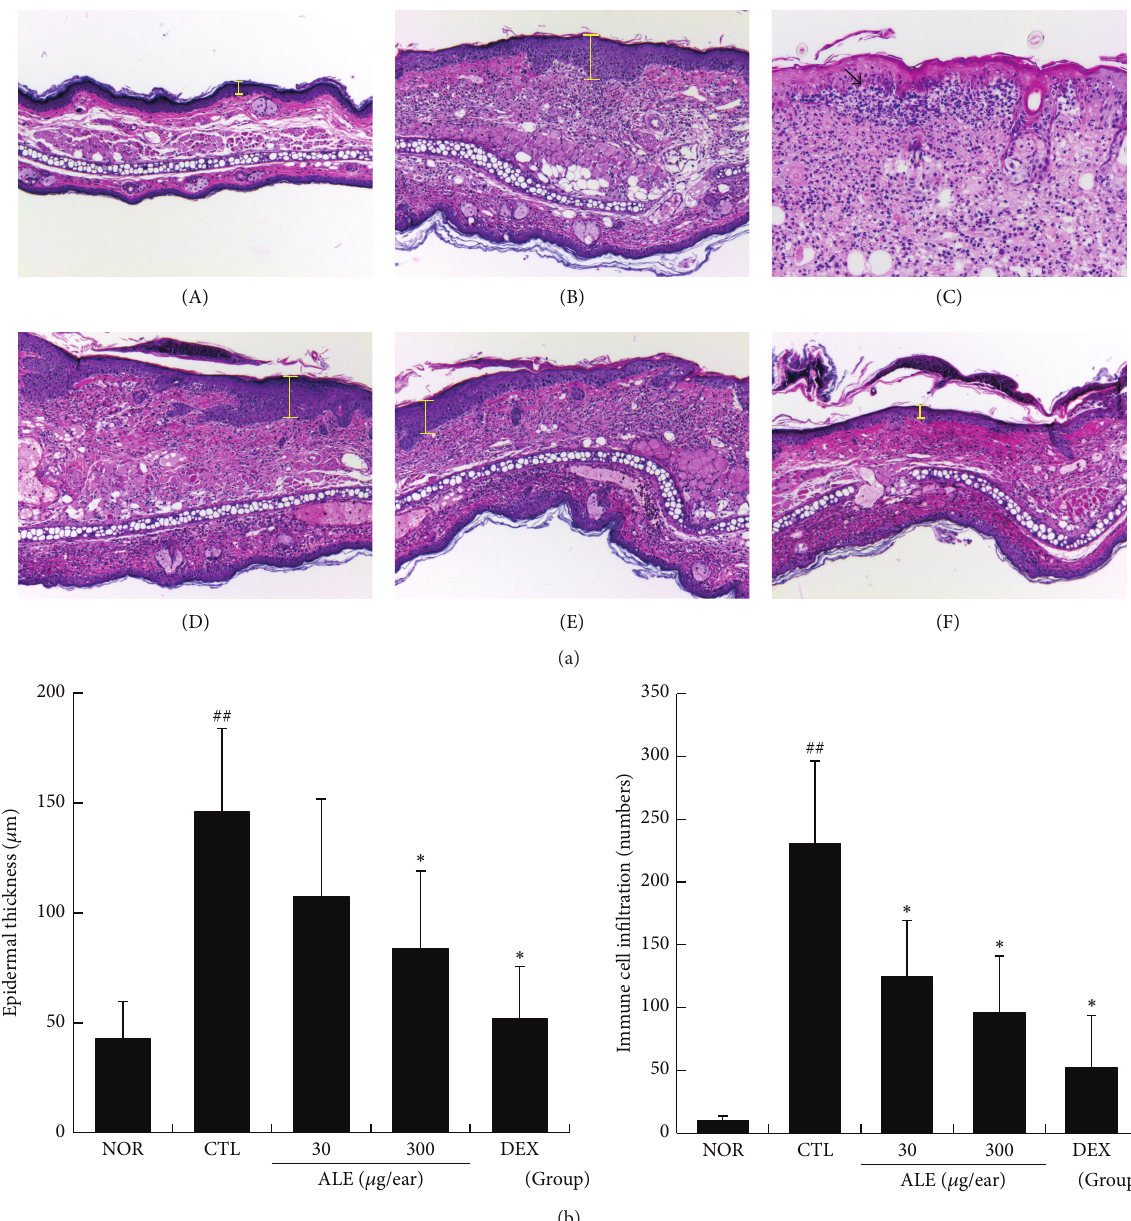
Figure 3: Effect of ALE on epidermal hyperplasia and infiltration of immune cells in CD mice. Skin tissue was observed under a light microscope. (A) NOR; ((B) and (C)) CTL; (D) 30 𝜇 g/ear of ALE; (E) 300 𝜇 g/ear of ALE; (F) 75 𝜇 g/ear of DEX. Magnification, 50x. Yellow bars indicate the epidermis. Filled arrows indicate pustule areas (a). The epidermal thickness (A) and infiltration of immune cells (B) were evaluated using a quantitative method. Abbreviations are the same as in Figure 2. (b). Values are presented as the means ± SD. ## 𝑃 < 0.01 compared to the NOR group and ∗ 𝑃 < 0.05 compared to the CTL